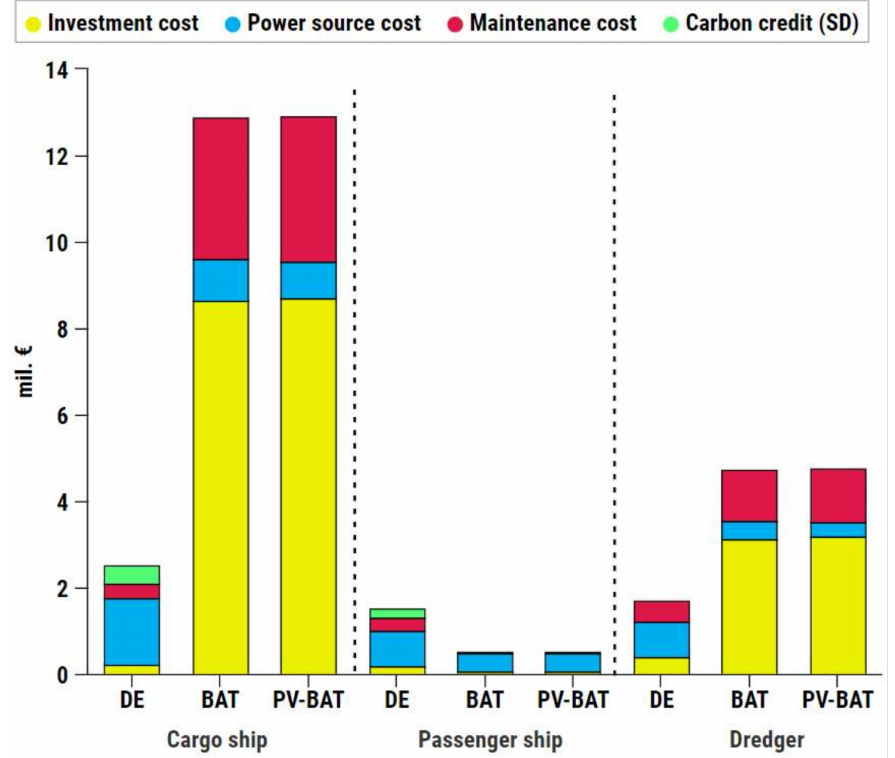
Figure 12. LCCA comparison of different power system configurations for the retrofit of the selected